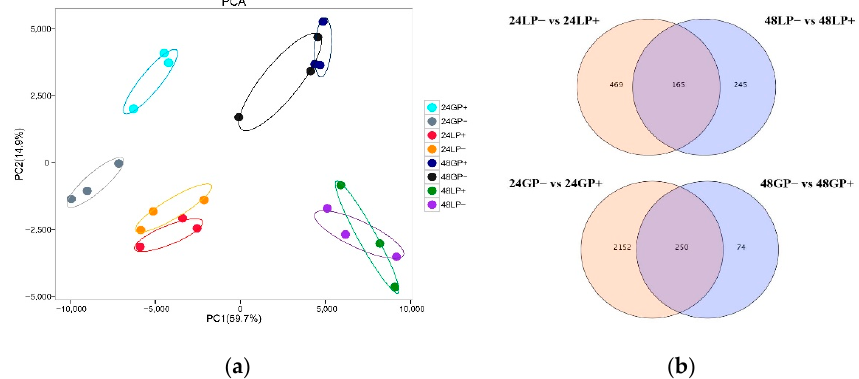
Figure 3. Transcriptome sequencing results of G and L varieties under PQQ treatment. ( a ) Principal component analysis (PCA) of transcriptome samples. “24 or 48” represent hours after inoculation, “P+ or P − ” represent PQQ or ddH 2 O treatment, respectively. ( b ) Venn diagram showing the intersection of DEGs.